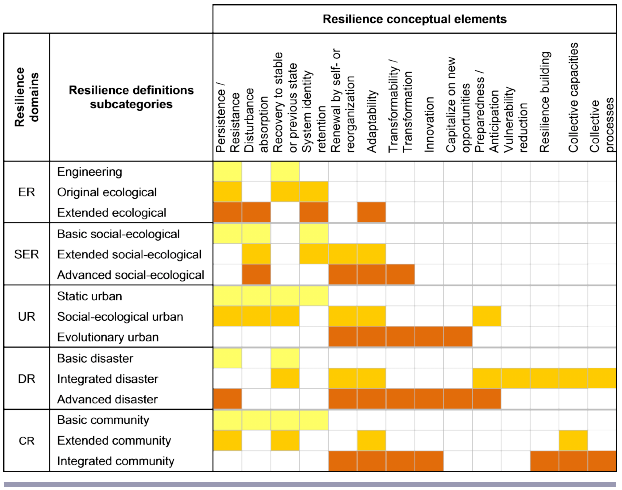
Fig. 1 . Key resilience conceptual elements identified in